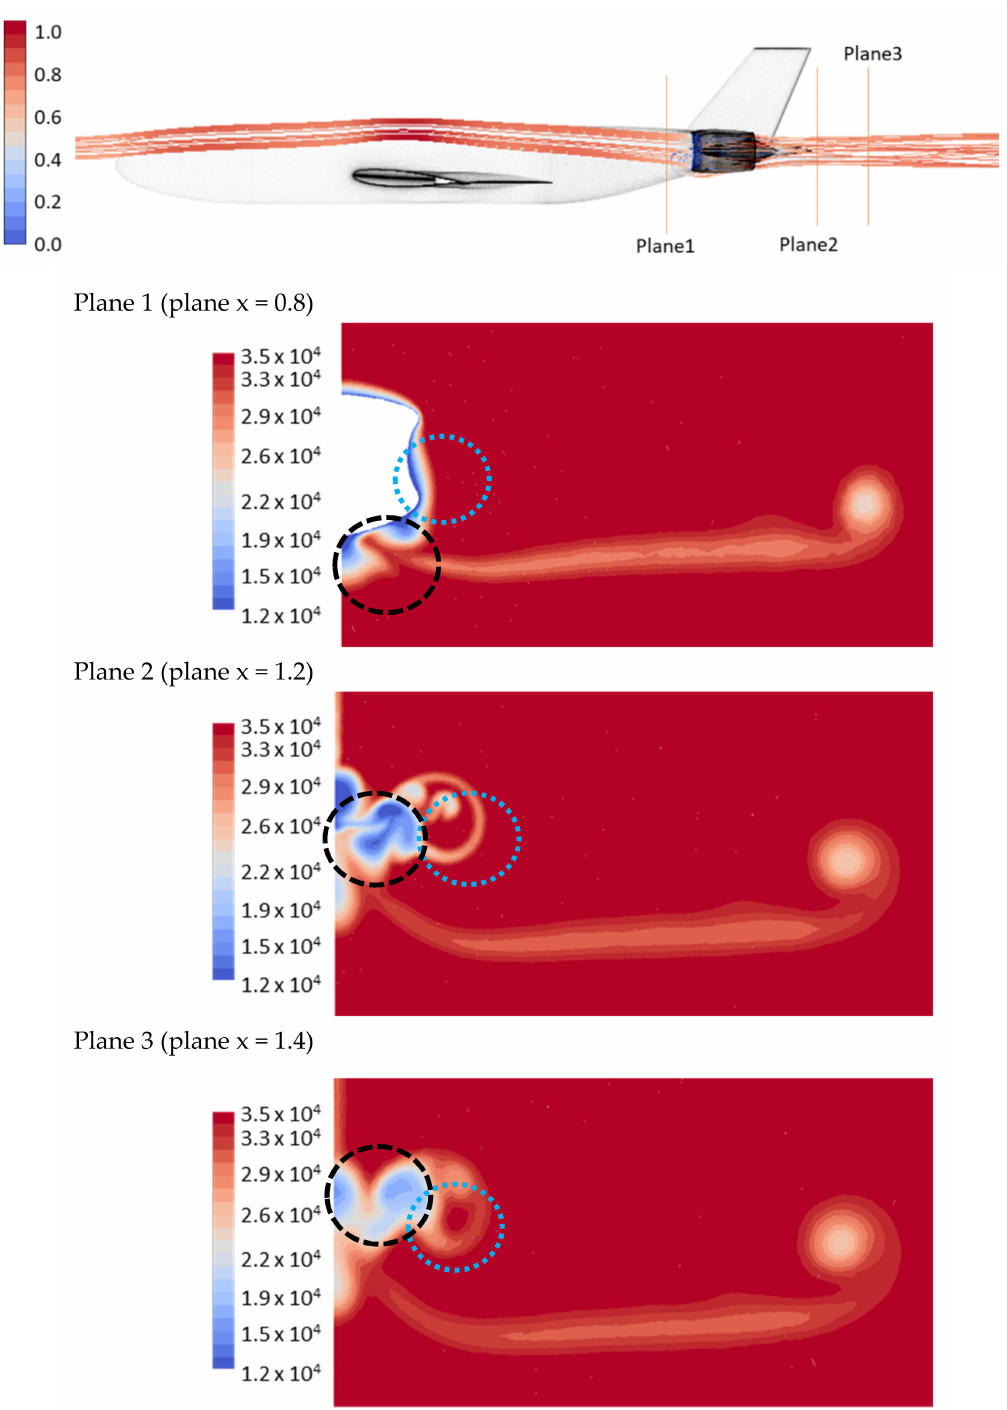
Figure 14. Pathlines towards the inlet of the engine ( top ) and the contours of the total pressure [Pa] in the planes of interest ( from the second to the last : Plane 1, Plane 2 and Plane 3), results from the 3D simulation of case h / D = 0.6, e / D = 0, l a / D = l b / D =